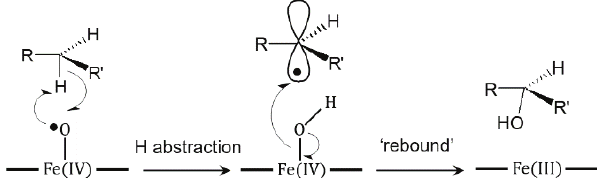
Scheme 2: Proposed reaction mechanism for hydroxylation of a substrate from the ferryl ion radical [29]. In the diagram the thick black lines represent the plane of the